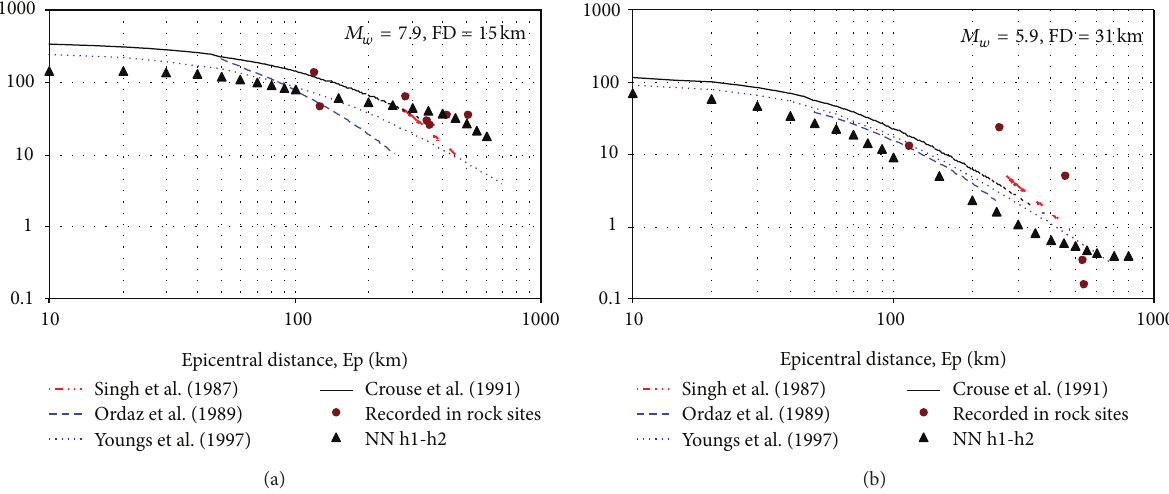
Figure 13: Attenuation relationship obtained with the proposed neural attenuation model PGAh1-h2 for two subduction-related events: (a)